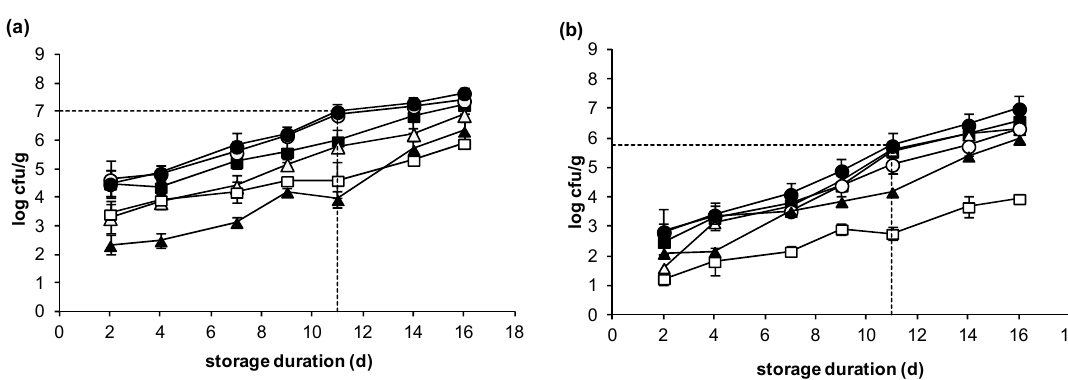
Figure 2. Microbiological changes during storage of ( a ) sea bass fillets and ( b ) salmon slices at 2 °C under MAP. Total viable count ( ● ), Enterobacteriaceae ( □ ), Brochothrix thermosphacta ( ▲ ), Pseudomonas spp. ( ○ ), Lactic acid bacteria ( Δ ) and H 2 S producing bacteria ( ■ ). Each data point and the error bars show the mean ± standard deviation of 4 replicates. The cross-section of dashed lines indicates the point of sensory rejection (11 days).